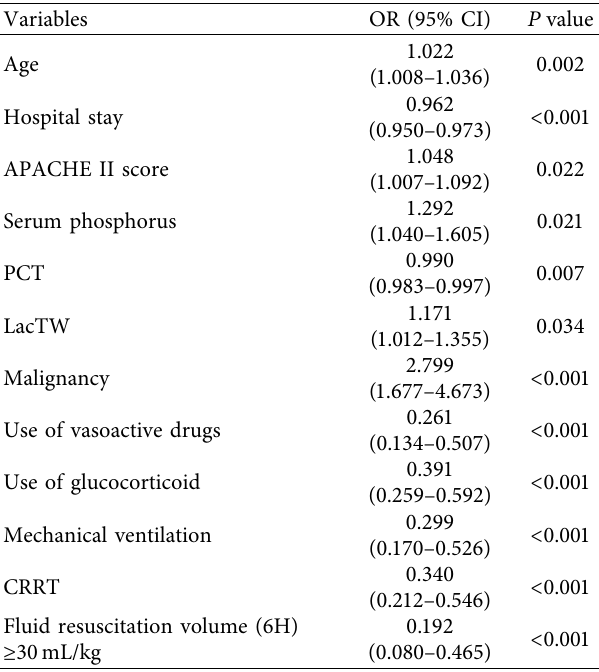
Table 2: Multivariate analysis of predictive factors for hospitali- zation mortality of the whole participants.